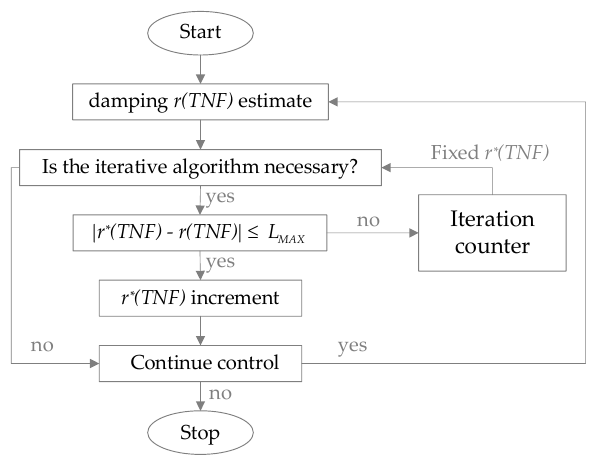
Figure 4. Iterative algorithm providing the adaptive reference generation for the phase control sys- tem.